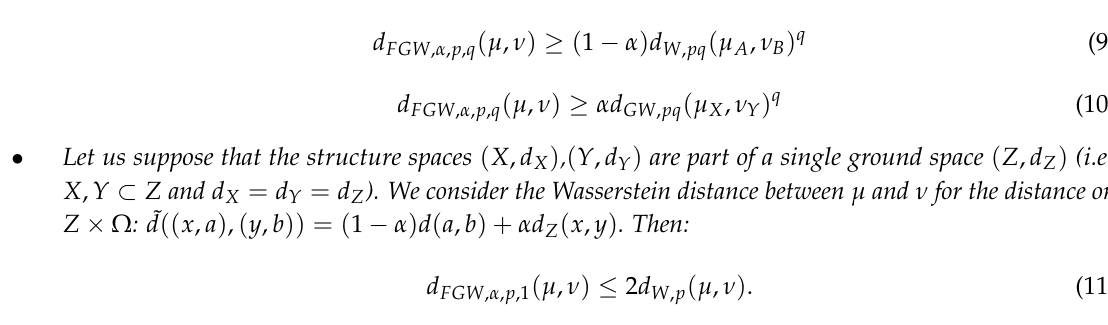
Figure 7. Illustration of Definition 8. The figure shows two structured objects ( X × Ω , d X , µ ) and ( Y × Ω , d ) . The feature space Ω is the common space for all features. The two metric spaces ( X , d Y , µ and ( Y , d Y ) represent the structures of the two structured objects, the similarity between all pair-to-pair distances of the structure points is measured by L ( x , y , x (cid:48) , y (cid:48) ) . µ and ν are the joint measures on the structure space and the feature